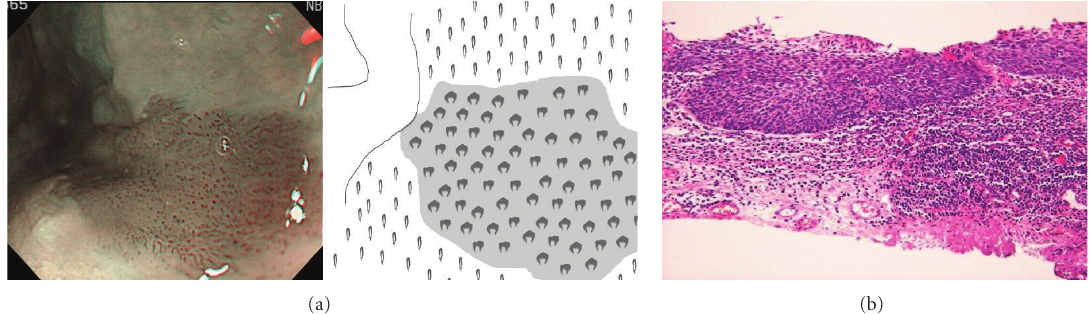
Figure 2: (a) Positive for background coloration (left panel). Color of the space between each dilated IPCL is brownish compared to normal IPCL area, as pointed out in schema (right image). (b) Endoscopic resection was carried out. Pathological result was T1a-LPM squamous cell carcinoma (squamous cell carcinoma, moderately di ff erentiated type, pT1a-LPM, INFb, ly0, v0, pHM0, pVM0).